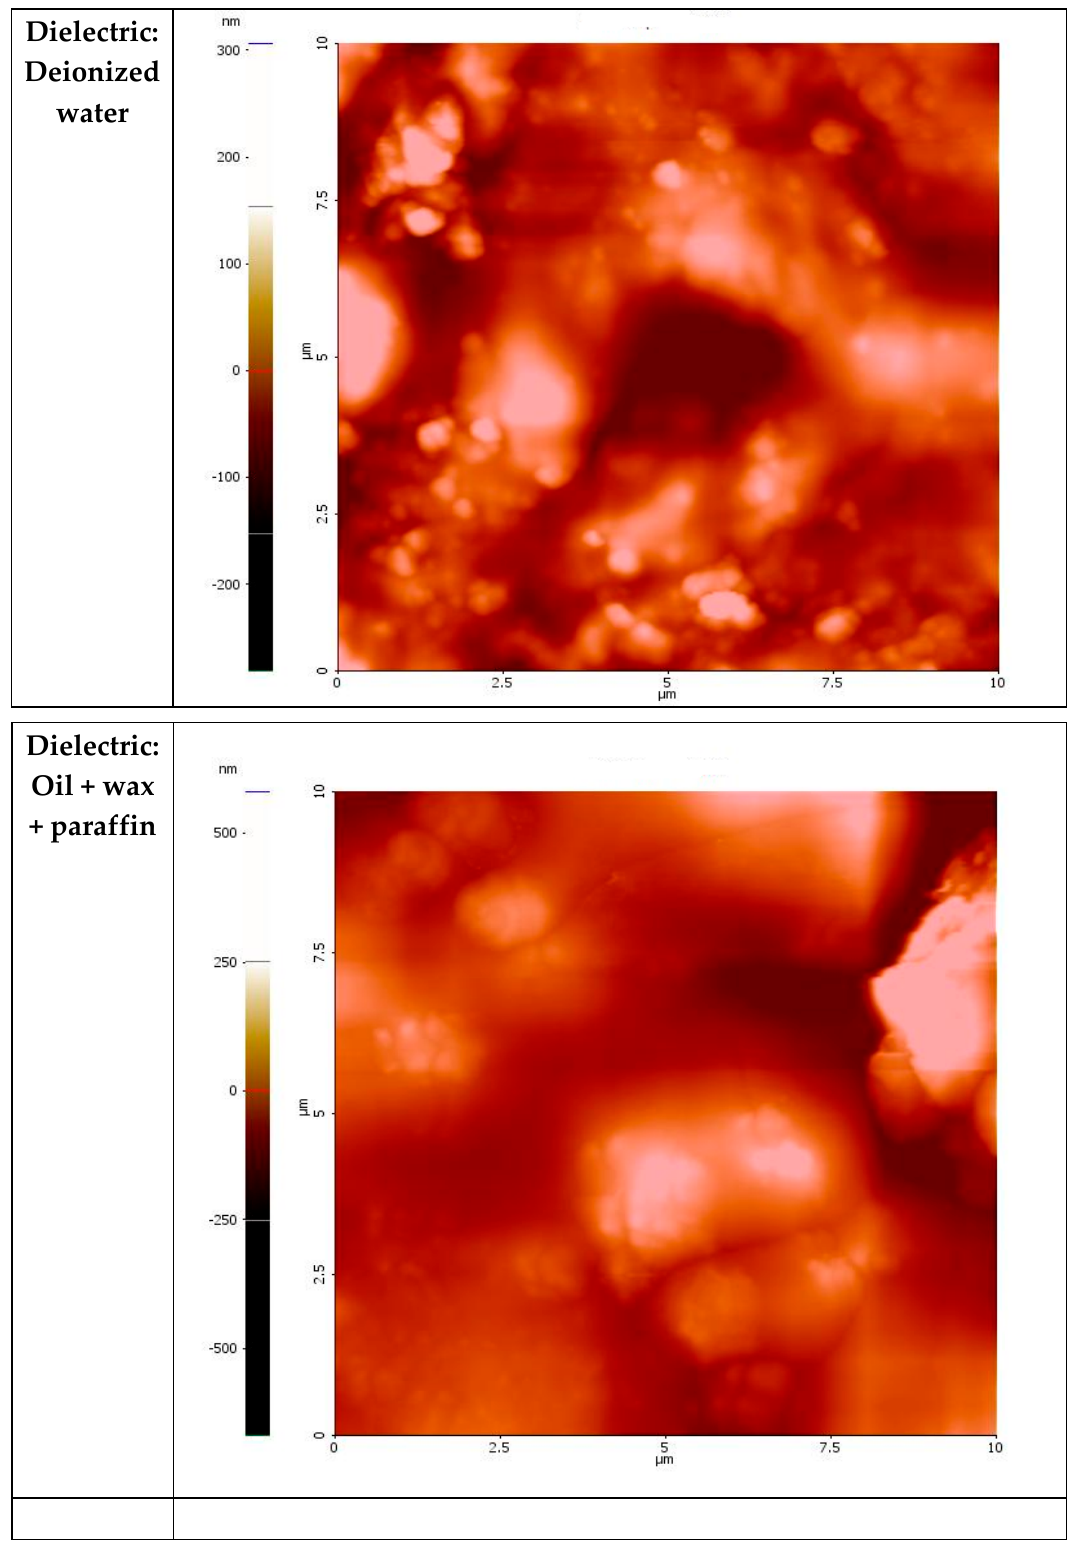
Figure 14. Atomic force microscopy image of the wire electrical discharge machined Al-SiC-TiC metal matrix surface. Table 13. Topographical analysis of the wire electrical discharge machined Al-SiC-TiC metal matrix composite.